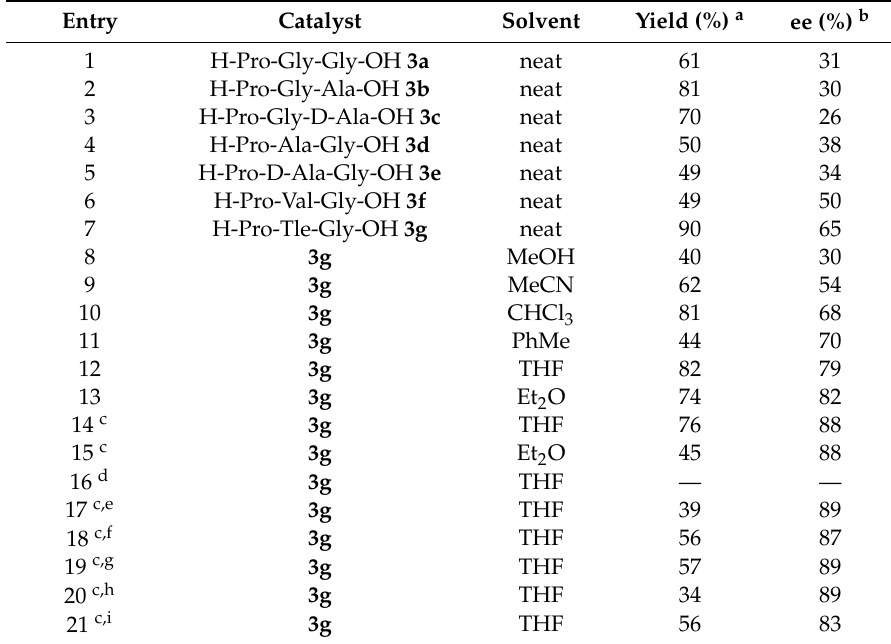
Table 1. Optimization of catalysts and reaction